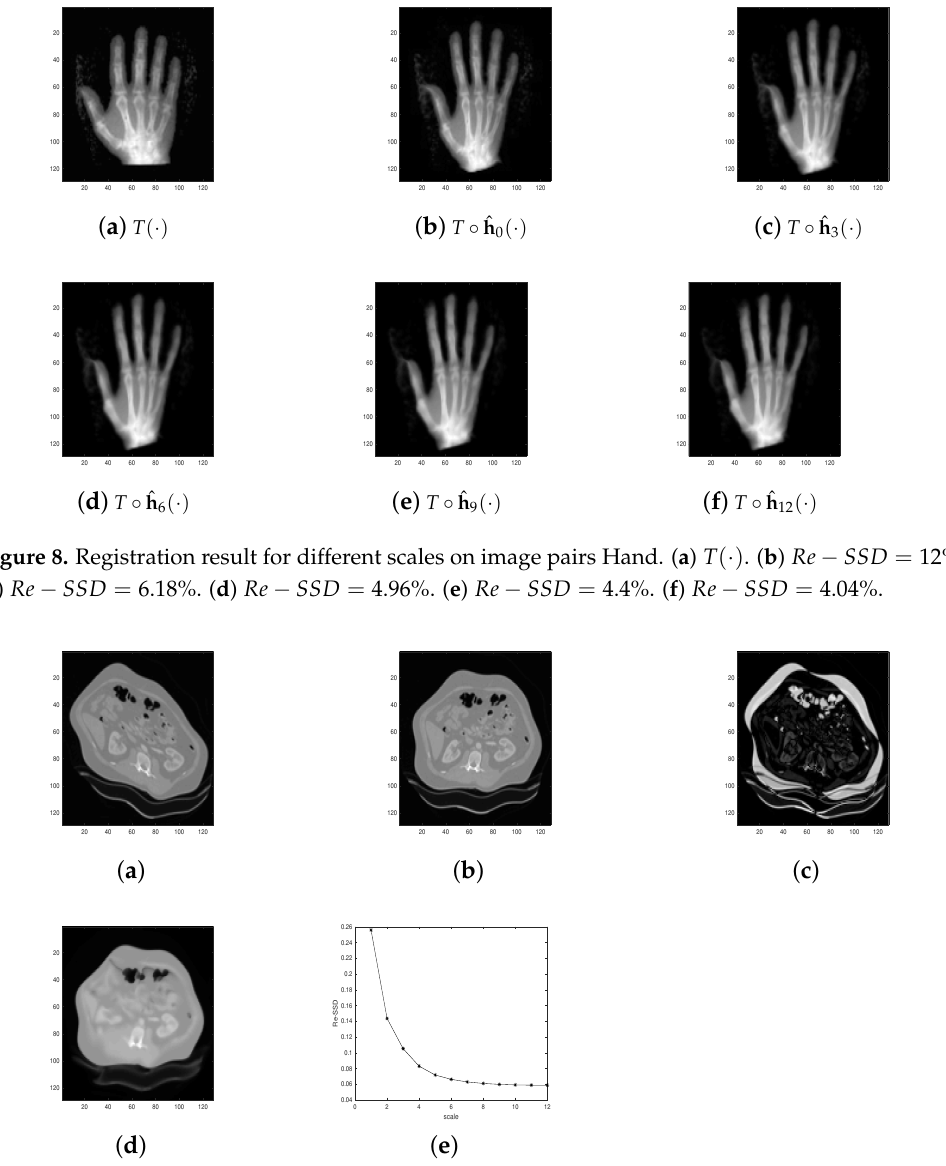
Figure 9. Registration result of Algorithm 2 on image pairs Liver. ( a ) T ( · ) . ( b ) D ( · ) . ( c ) | T − D | . ( · ) . ( e ) Re − SSD change (Liver) with scale ( d ) T ◦ ˆ h K M